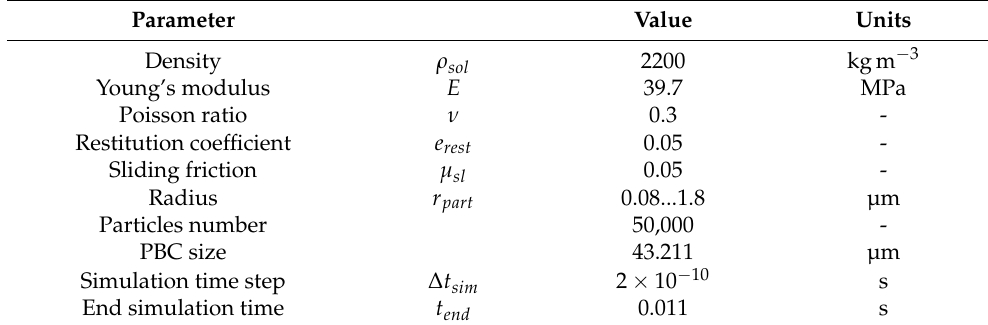
Table 2. Parameters used in DEM simulations.